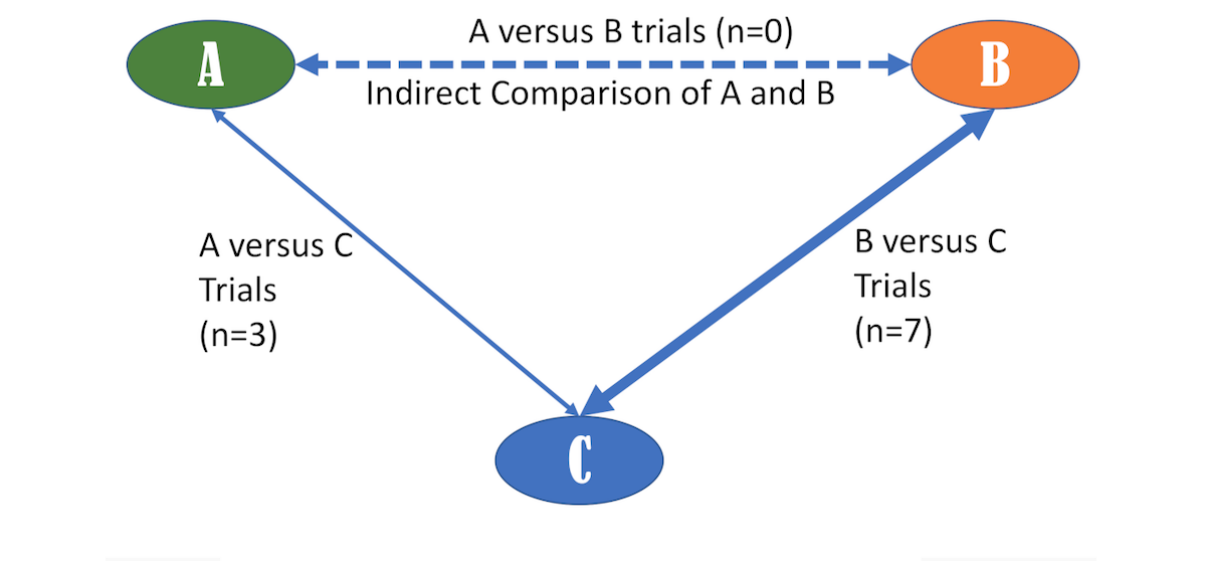
Figure 1. Adjusted indirect comparison network meta-analysis framework. A: mhealth delivered; B: face to face; C: standard of